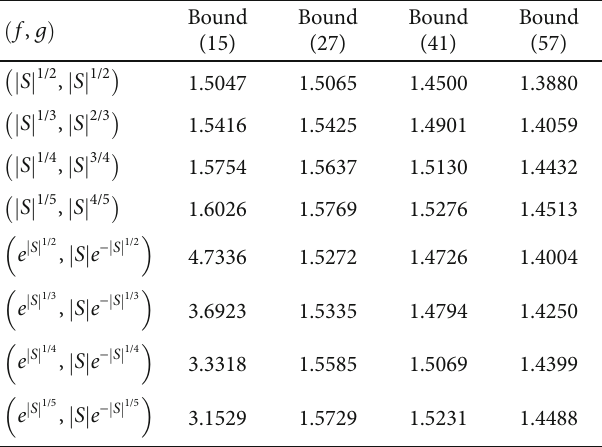
Table 3: Bounds (15), (27), (41), and (57) for di ff erent choices of f and g in (10). f , g ð